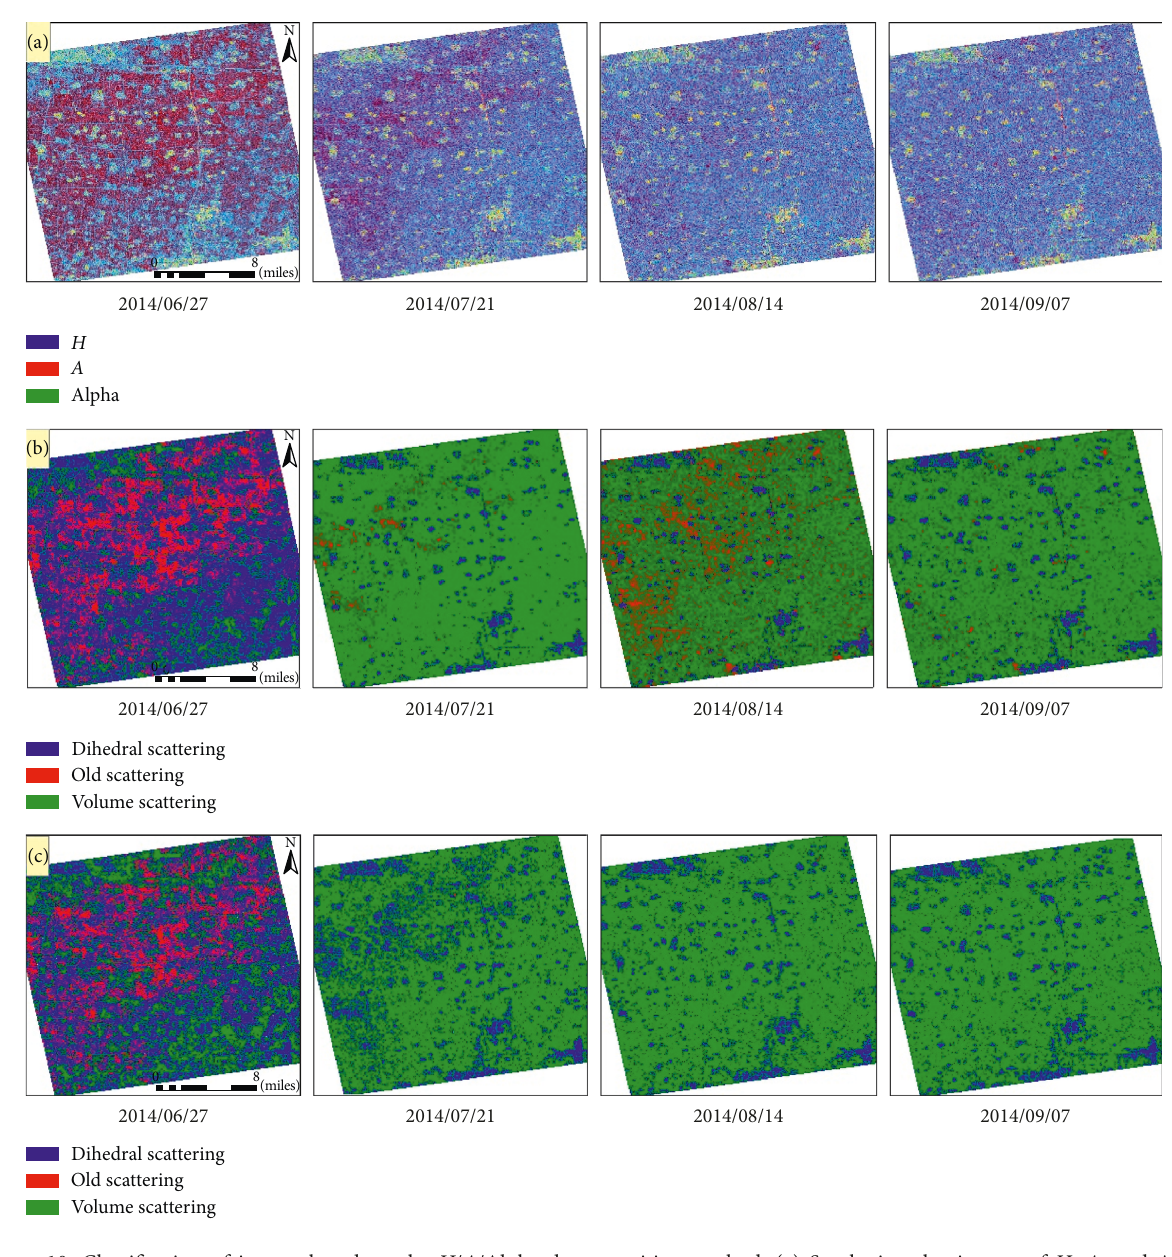
Figure 10: Classification of images based on the H / A /Alpha decomposition method. (a) Synthetic color images of H , A , and Alpha. (b) Images obtained using the maximum-likelihood method. (c) Images obtained using the threshold